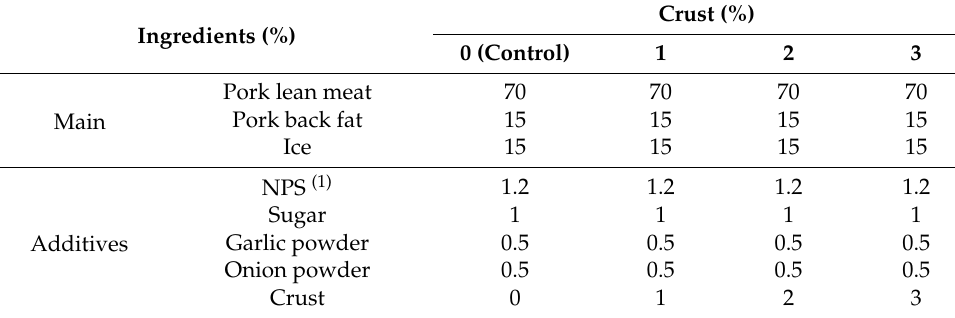
Table 1. Formulation of the pork patties used in this